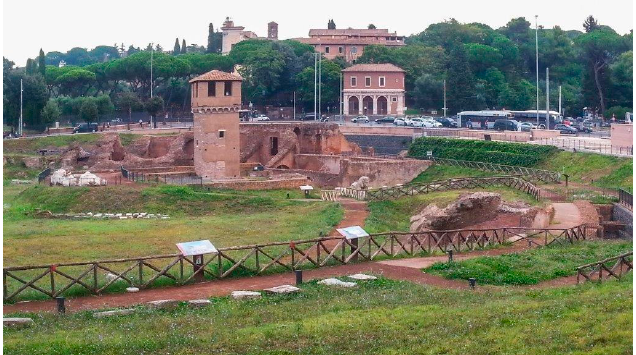
Figure 1. Europe plan and plan view of the Circus Maximus (satellite image available at http://www.pcn.minambiente.it/mattm/servizio-wms/, accessed on 23 September 2021).